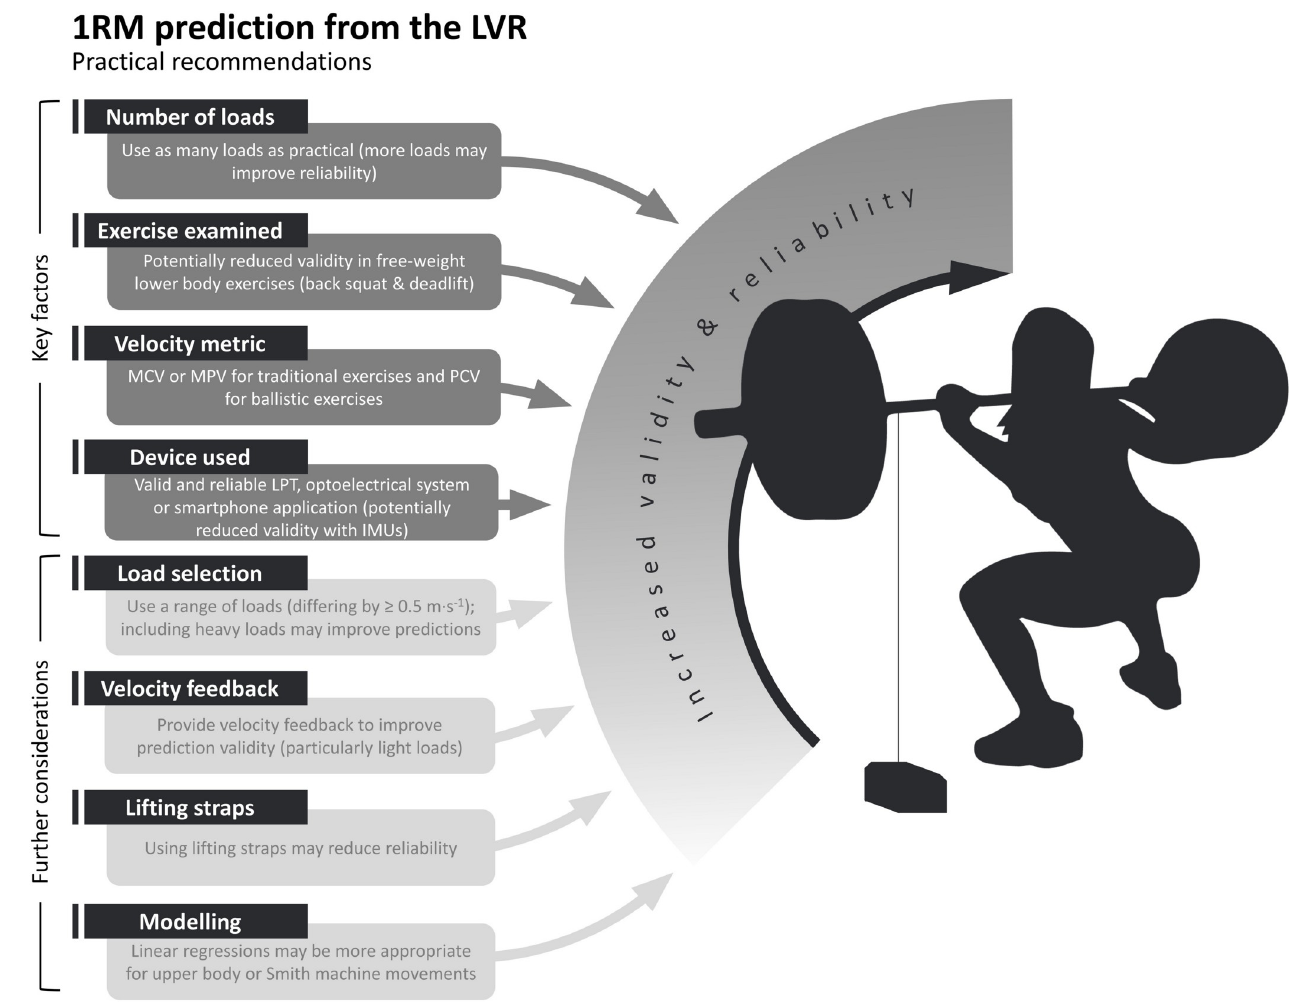
Fig 7. Summary of the practical recommendations for use of a LVR to predict